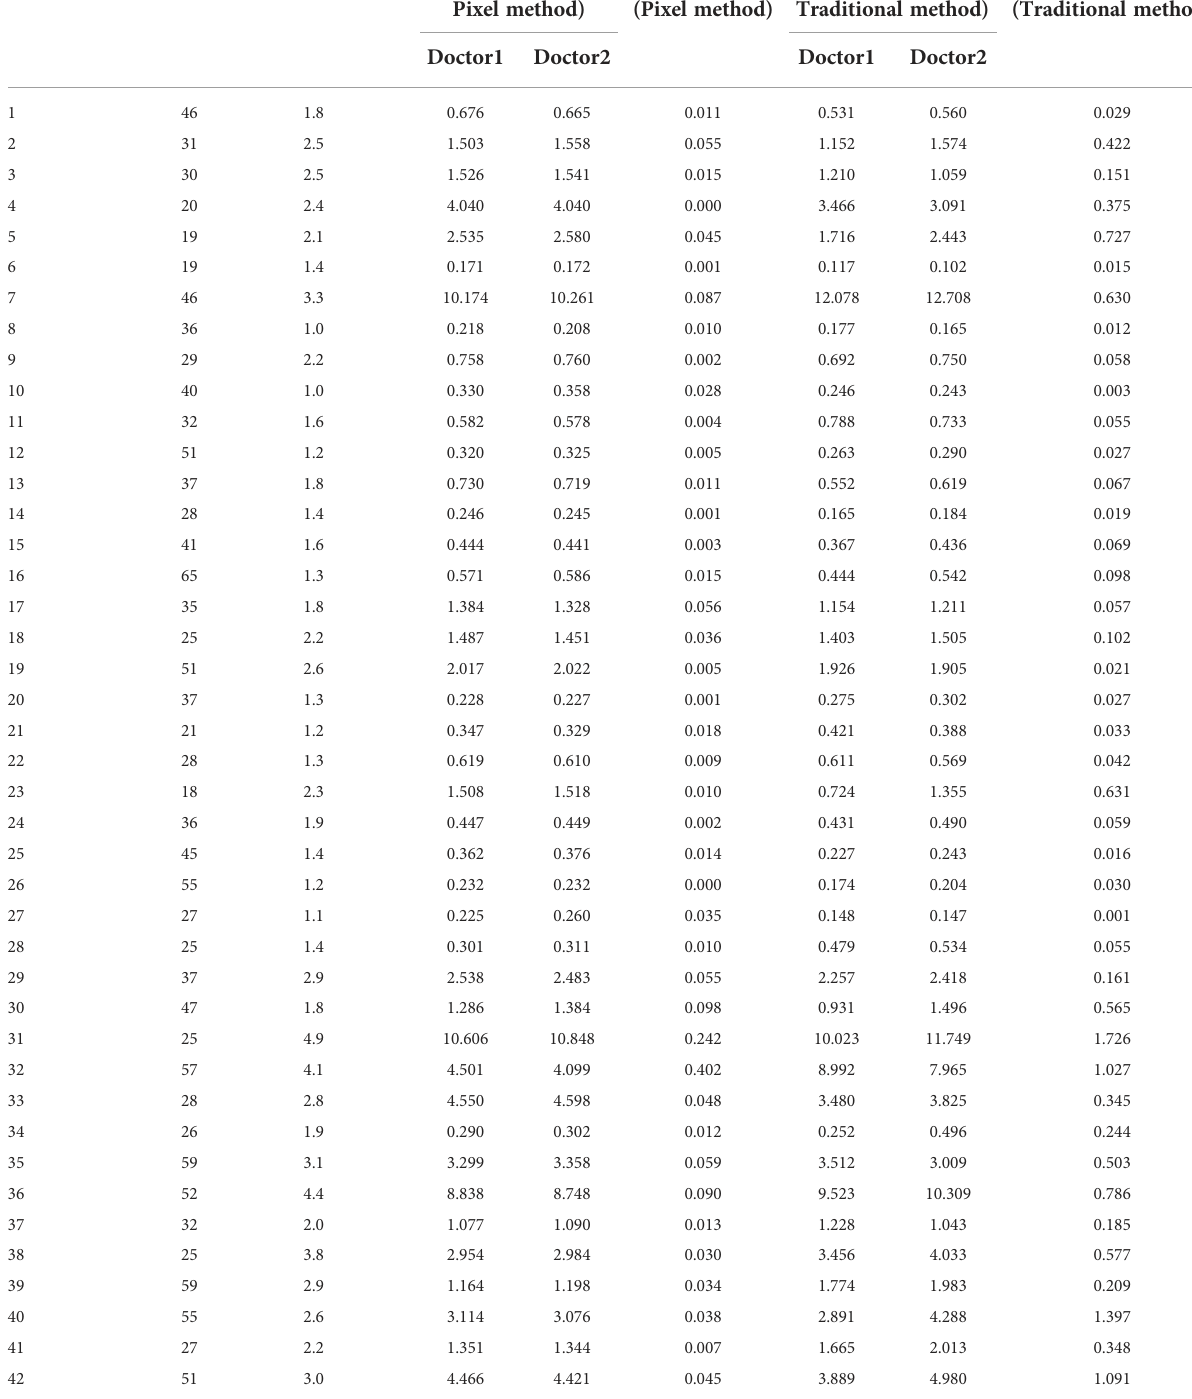
TABLE 1 Patient age and tumor length, and difference in tumor volumes measured by two physicians using either the pixel or traditional method. Patient number Age Tumor length (cm) Tumor volume (cm 3